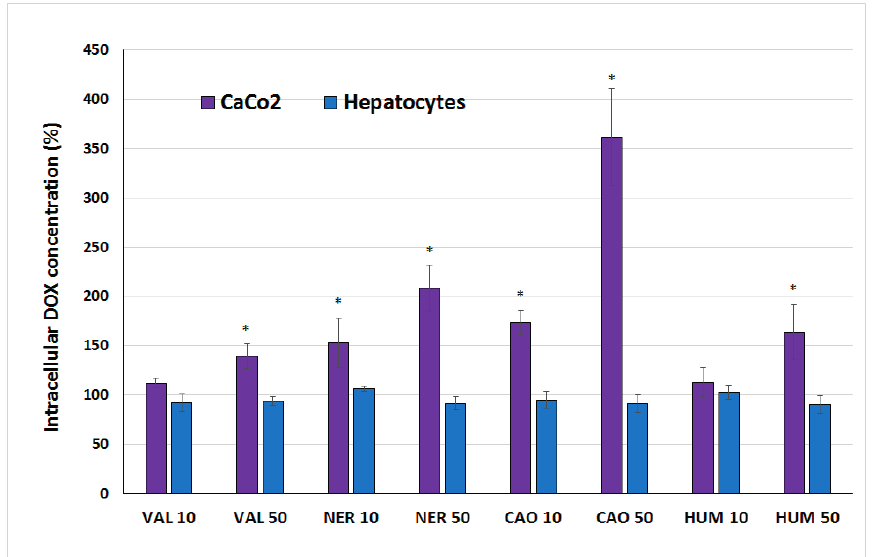
Figure 8. Effect of sesquiterpenes (10 and 50 µg/mL) on DOX intracellular concentration in CaCo-2 cells and hepatocytes. Data (mean ± S.D. from triplicates) are expressed as percentage of DOX intracellular concentration in cells treated with DOX alone (=100%). The asterisk indicates a significant difference from the control cells ( p <